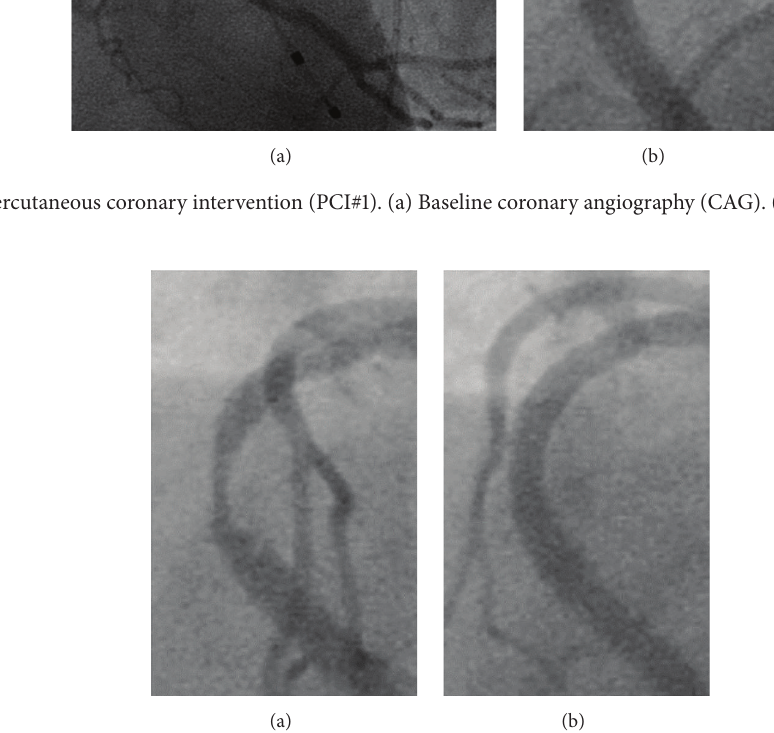
Figure 2: Second percutaneous coronary intervention (PCI#2). (a) Baseline coronary angiography (CAG). (b) CAG after second stenting.